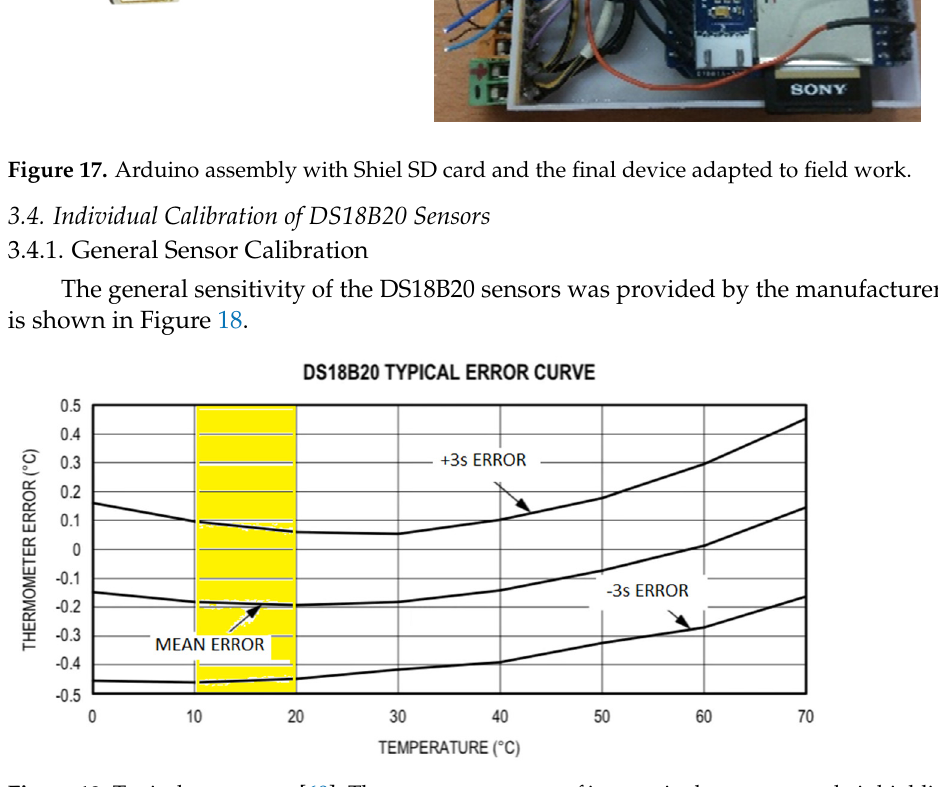
Figure 18. Typical error curve [60]. The temperature zone of interest in the current study is highlighted in the box.